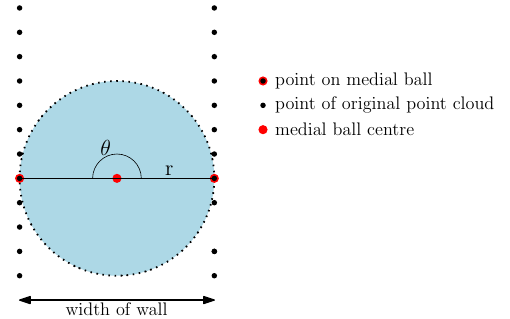
Figure 7. Local geometry of a medial ball (blue) inside a wall